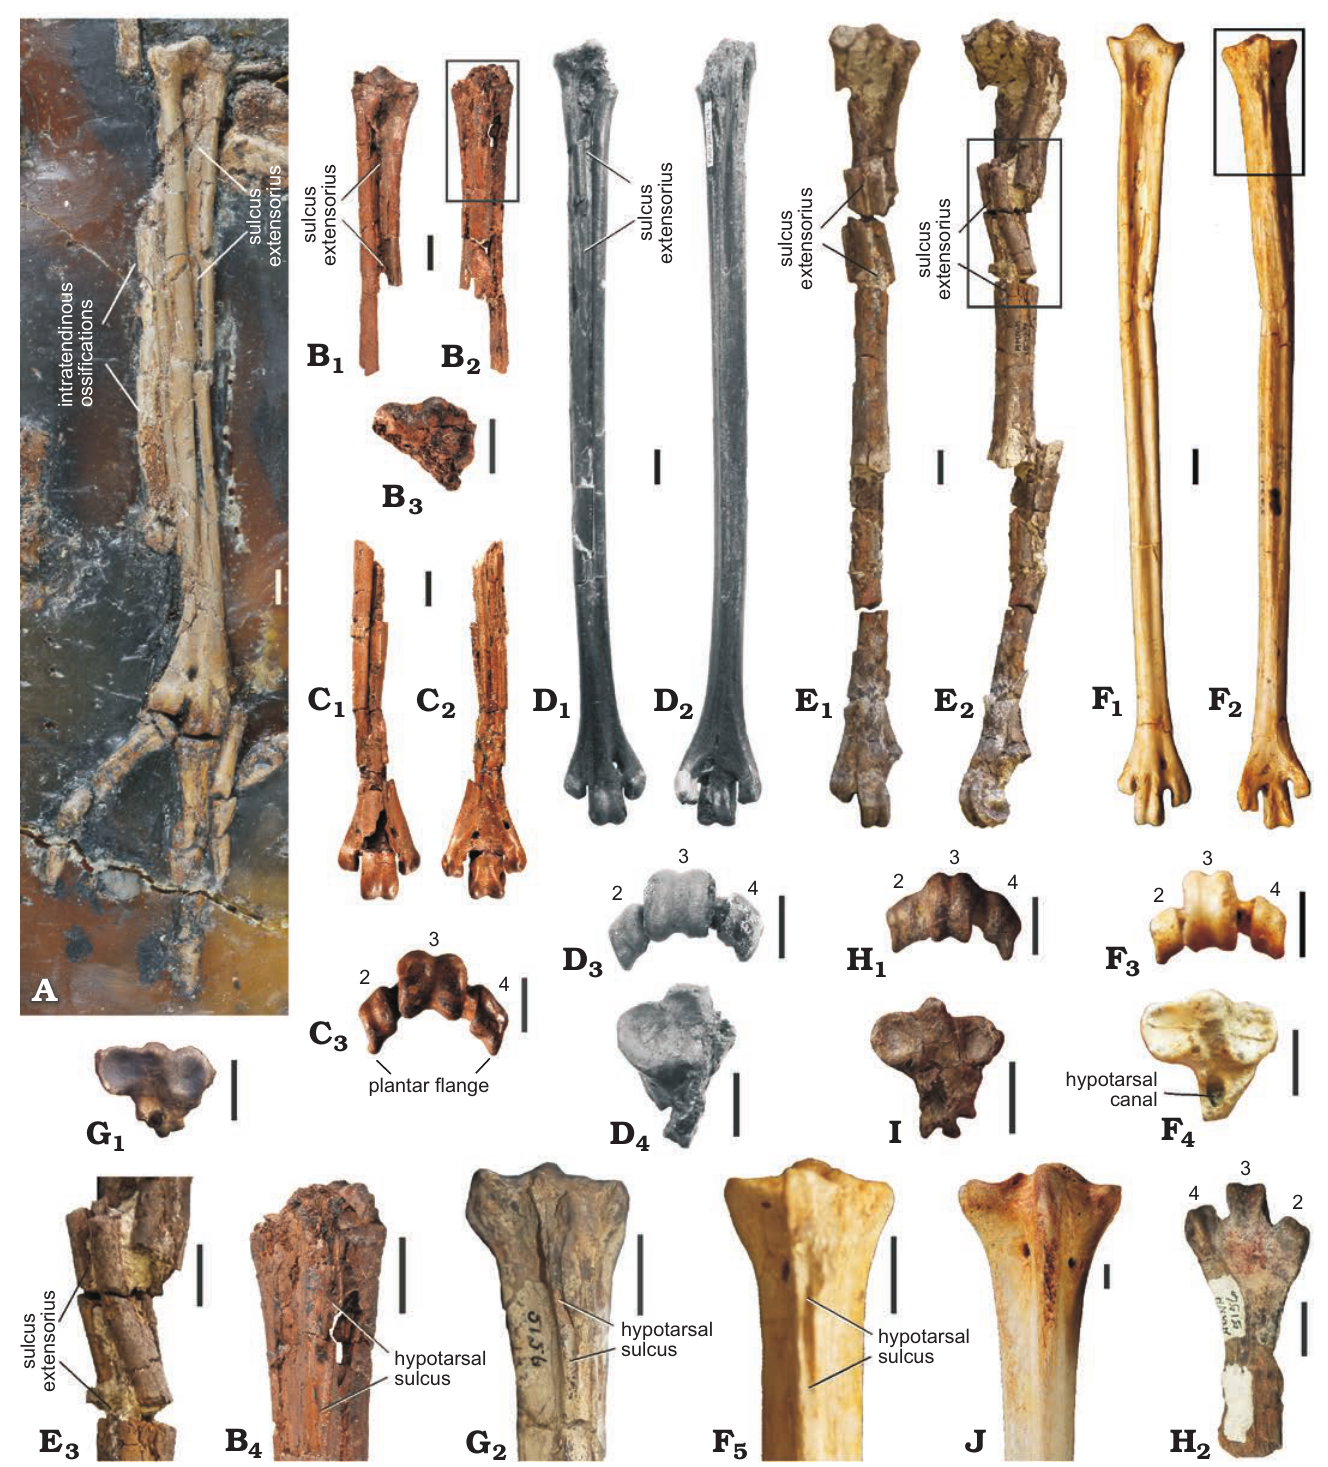
Fig. 3. Tarsometatarsi of palaeotidid, geranoidid, eogruid, and struthionid birds. A – C . Palaeotis weigelti Lambrecht, 1928 (Palaeotididae) from the middle Eocene of the Geiseltal, Germany. A . GMH 4362; right tarsometatarsus in dorsal view. B . GMH IX-566-1953; proximal end of right tarsometa- tarsus in dorsal (B 1 ), plantar (B 2 , B 4 ), and proximal (B 3 ) views. C . Holotype: GMH 4416; distal end of left tarsometatarsus in dorsal (C 1 ), plantar (C 2 ), and distal (C 3 ) views. D . Galligeranoides boriensis Bourdon, Mourer-Chauviré, and Laurent, 2016 (Palaeotididae) from the early Eocene of southern France, MHNT.PAL.2013.16.2; right tarsometatarsus in dorsal (D 1 ), plantar (D 2 ), distal (D 3 ), and proximal (D 4 ) views (from Bourdon et al. 2016; D 1 –D 3 mirrored). E . cf. Eogeranoides campivagus Cracraft, 1969 (Geranoididae) from the early Eocene of Wyoming, USA, AMNH 5127; left tarsometatarsus in dorsal (E 1 ) and dorsolateral (E 2 , E 3 ) views (the fossil consists of several fragments, which were assembled for the photo). F . Eogrus aeola Wetmore, 1934 (Eogruidae) from the middle Eocene of Inner Mongolia, China, AMNH 2937; right tarsometatarsus in dorsal (F 1 ), plantar (F 2 , F 5 ), distal (F 3 ), and